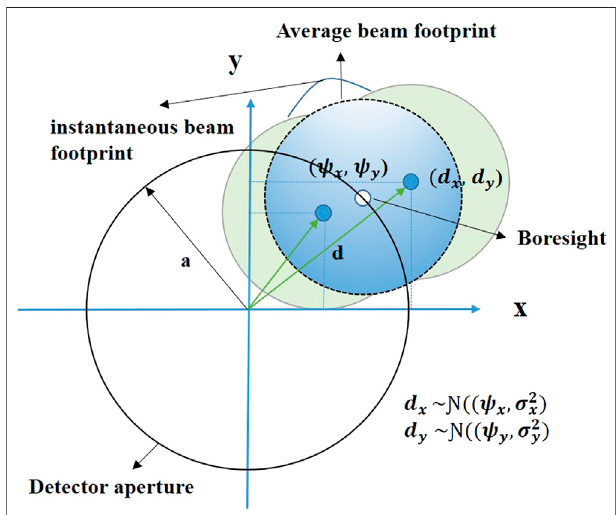
FIGURE 2 | Pointing errors in FSO